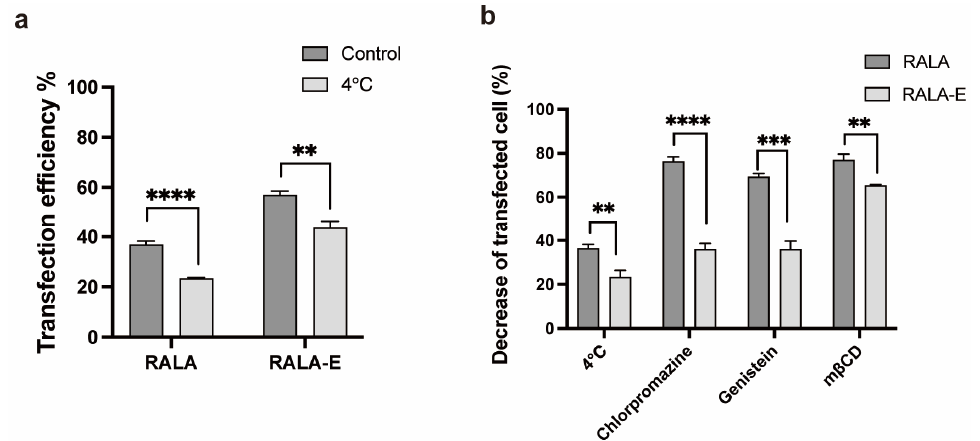
Figure 3. Endocytosis mechanism evaluation of RALA-E/pDNA on HEK-293T cells. ( a ) Transfection efficiency of RALA-E/pDNA under 4 ◦ C; ( b ) Effect of various endocytosis inhibitors on transfection efficiency of RALA-E/pDNA. ** p ≤ 0.01, *** p ≤ 0.001, **** p ≤